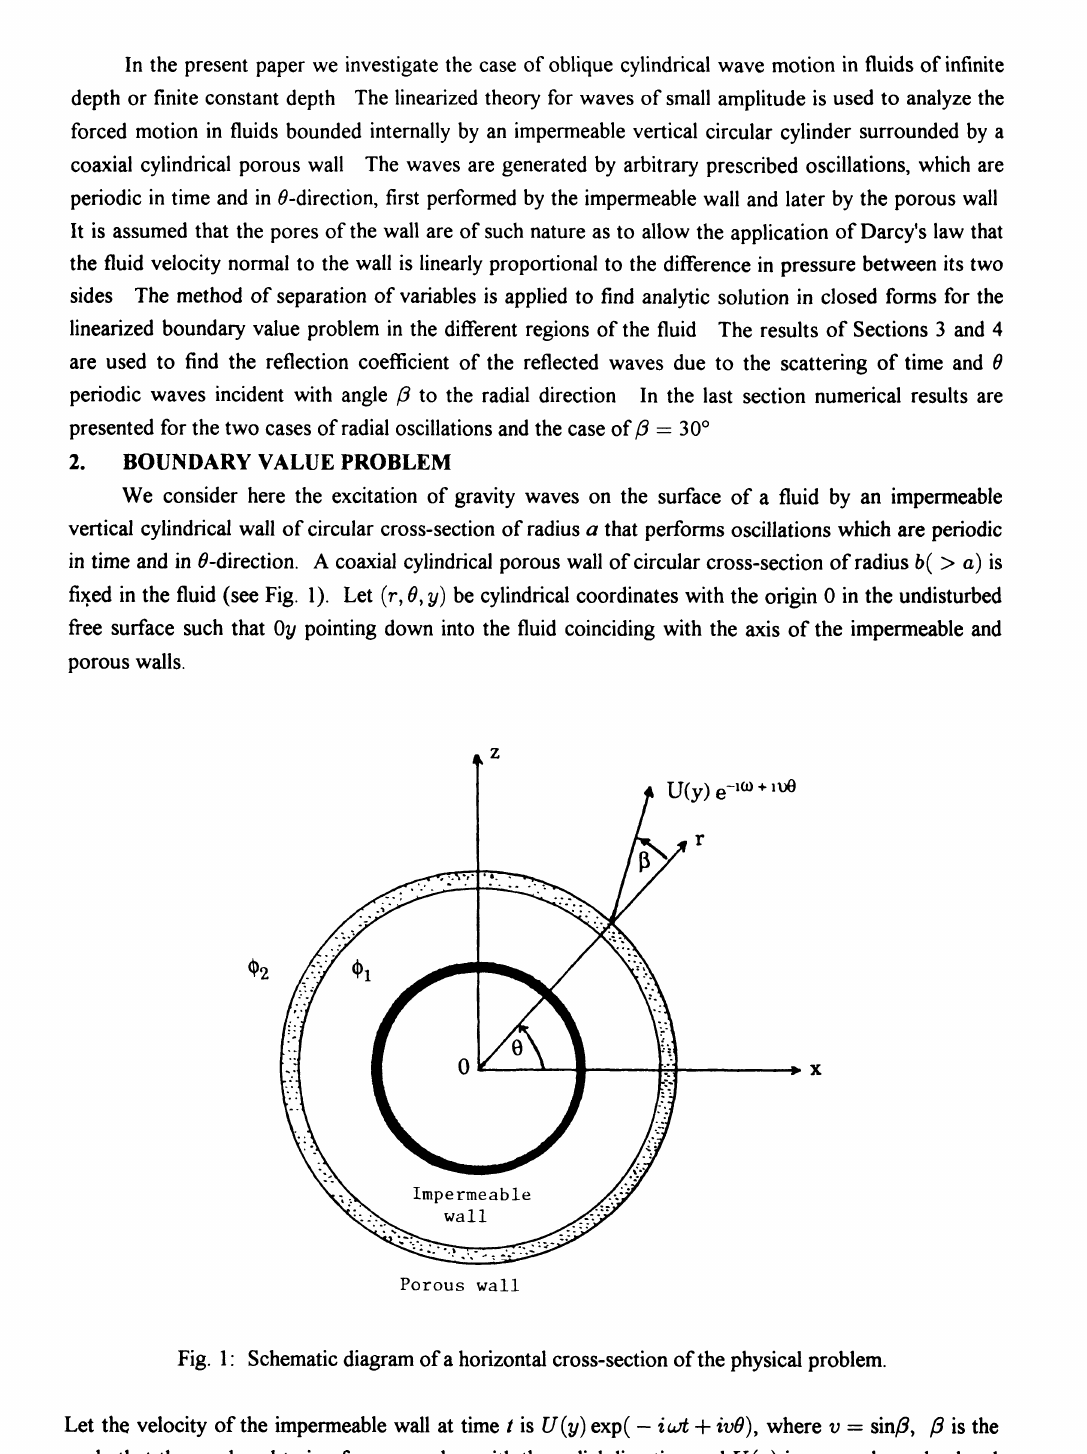
Fig. 1: Schematic diagram of a horizontal cross-section of the physical